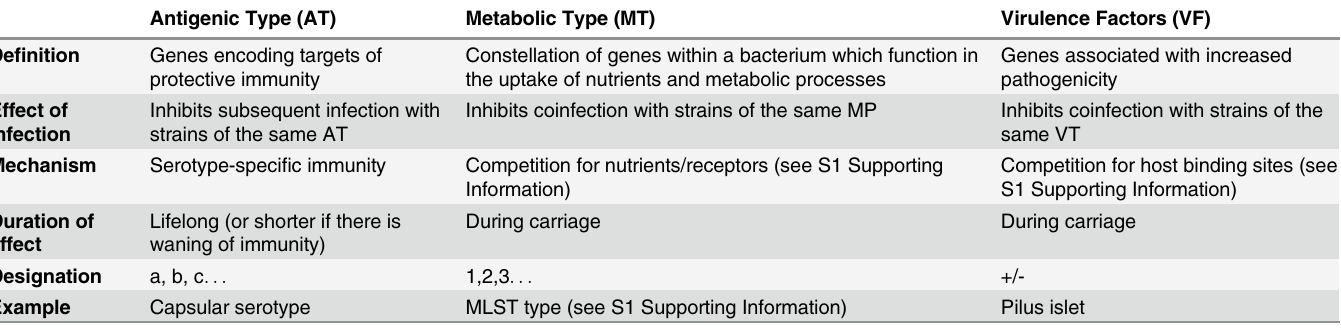
Table 1. Theoretical framework. Bacterial strains can be conceptualised as aggregates of of antigenic, metabolic and virulence components which are subject to immunological and direct competition. Antigenic Type (AT) Metabolic Type